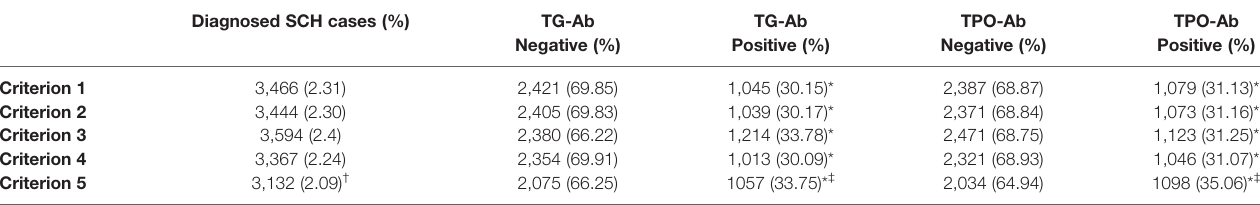
TABLE 5 | Diagnosis of SCH based on the diagnostic criteria and TSH concentration threshold of ≥ 6.5 mIU/L.